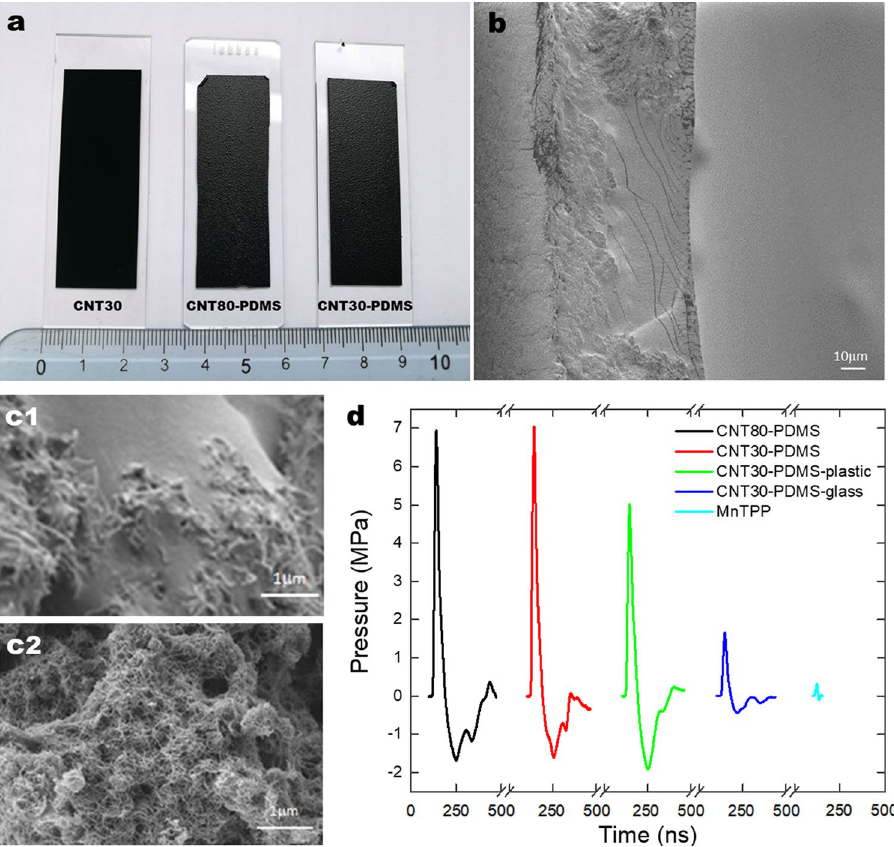
Figure 2. CNT-PMDS films. ( a ) Photographs of the films without PMDS (CNT30) or infused with PDMS and different thicknesses (CNT80-PDMS, CNT30-PDMS). ( b ) SEM micrograph of the cross section of CNT80- PDMS. The free surface is on the right and the interface with the glass slide on the left. ( c ) SEM micrographs of the surfaces of CNT80-PDMS ( c1 ) and of CNT30 ( c2 ). ( d ) Photoacoustic waves measured with hydrophone (arbitrary origins displaced in the x-axis for clarity of presentation of the acoustic waves, which have essentially the same travelling time between source and detector), obtained with laser pulses of 50 mJ/cm 2 at 532 nm; the temporal FWHM of the compressive wave generated by CNT30-PDMS is 25 ns.